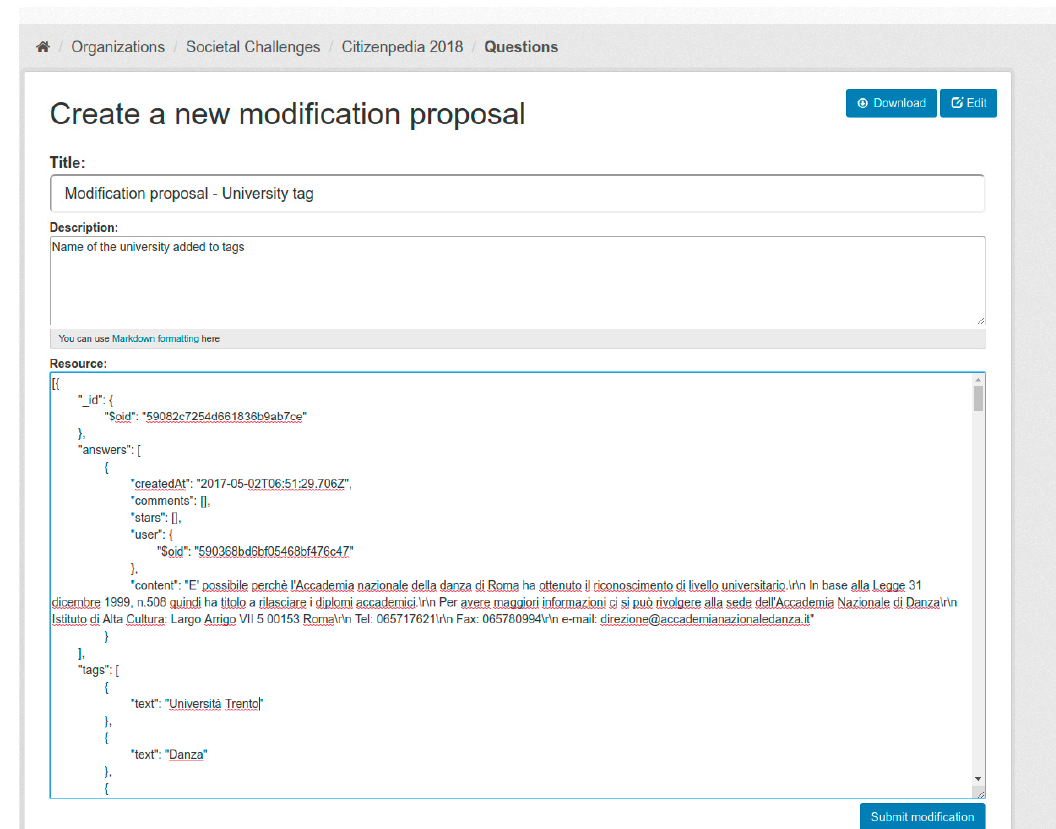
Figure 5. Form for user to submit modification request for dataset